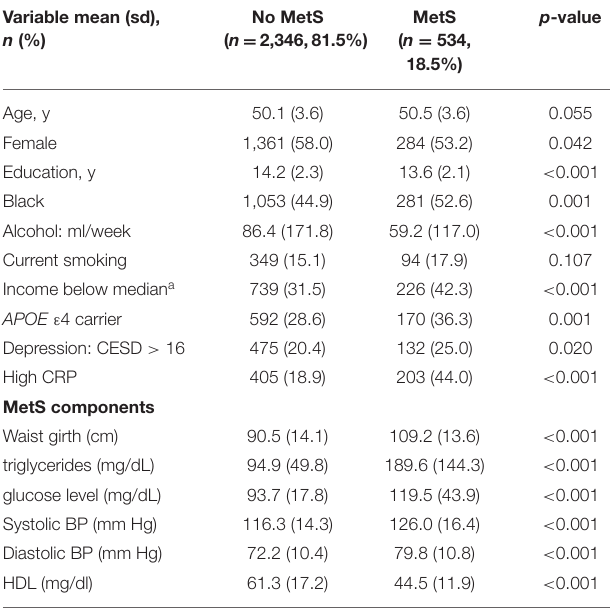
TABLE 1 | Characteristics of 2,880 CARDIA participants by metabolic syndrome at midlife. Variable mean (sd), n